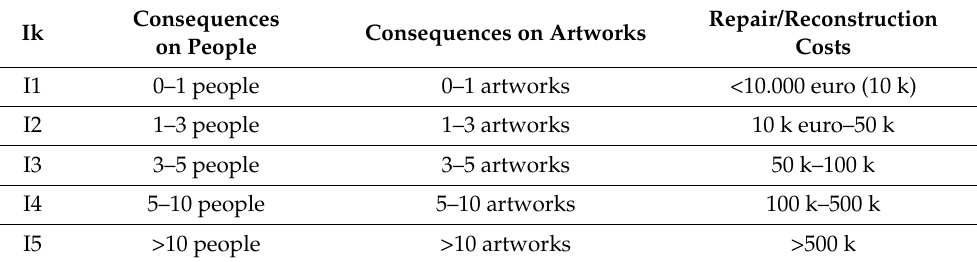
Table 12. Assumed impact levels Ik (k = 0–5) for the numerical ranges of the consequences estimated for people, artworks and direct losses in the ARCH DSS